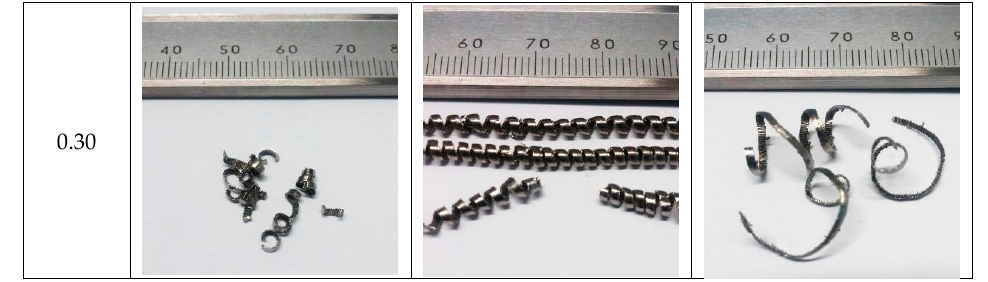
Figure 4. Evolution of the chip morphology as a function of cutting speed ( v c ) and feed rate ( f ).